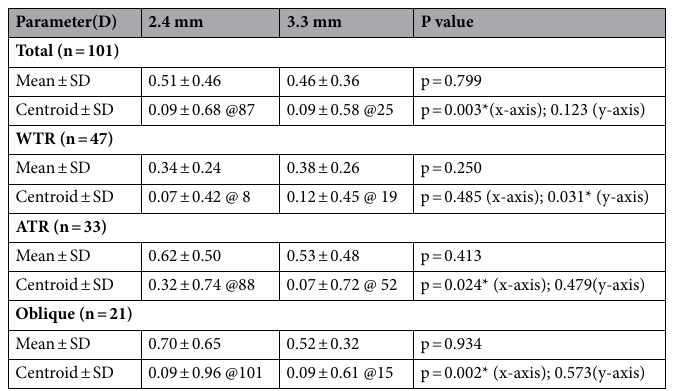
Table 3. Comparison of post-operative residual astigmatism prediction error at 2 diameter zones and subgroup analyses.